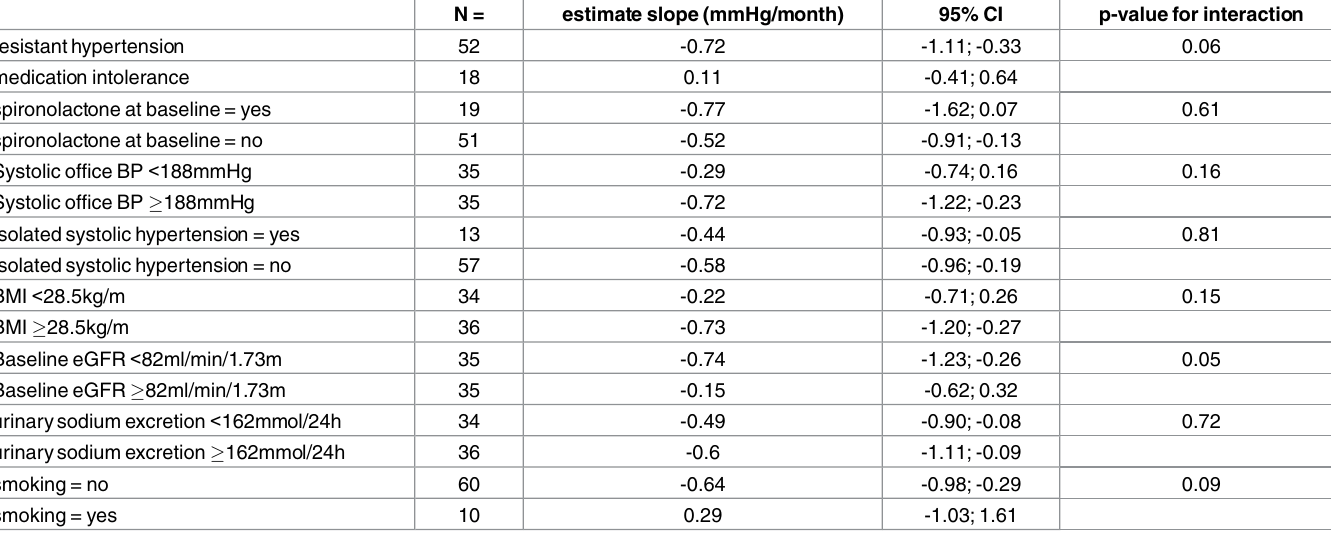
Table 3. Changein home bloodpressureover timeafterrenal denervationin various strataof